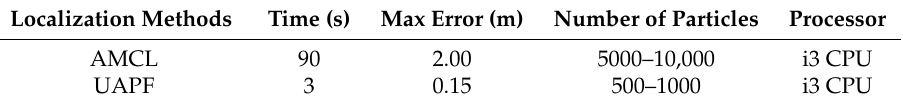
Table 5. Performance of robot kidnap recovery with UAPF and AMCL Localization